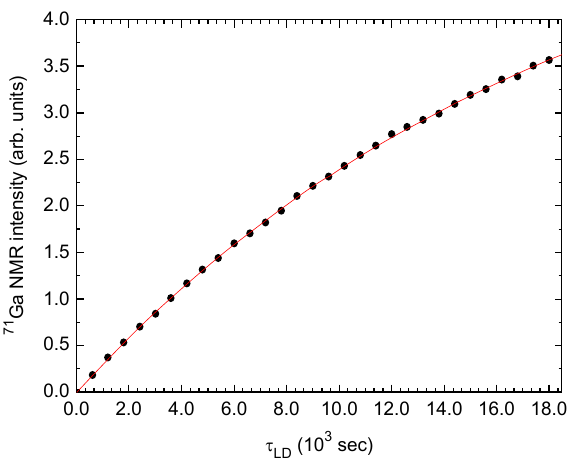
Fig. 1 71 Ga spin lattice relaxation in the dark. Spin lattice relaxation process of the 71 Ga nuclei measured with the saturation recovery sequence (Comb pulses - τ LD - π /2 pulse -FID) at 10 K and in the dark. The horizontal scale, τ LD is the long delay between the saturation pulses and the π /2 pulse. The solid curve is a fi t to the single exponential function.